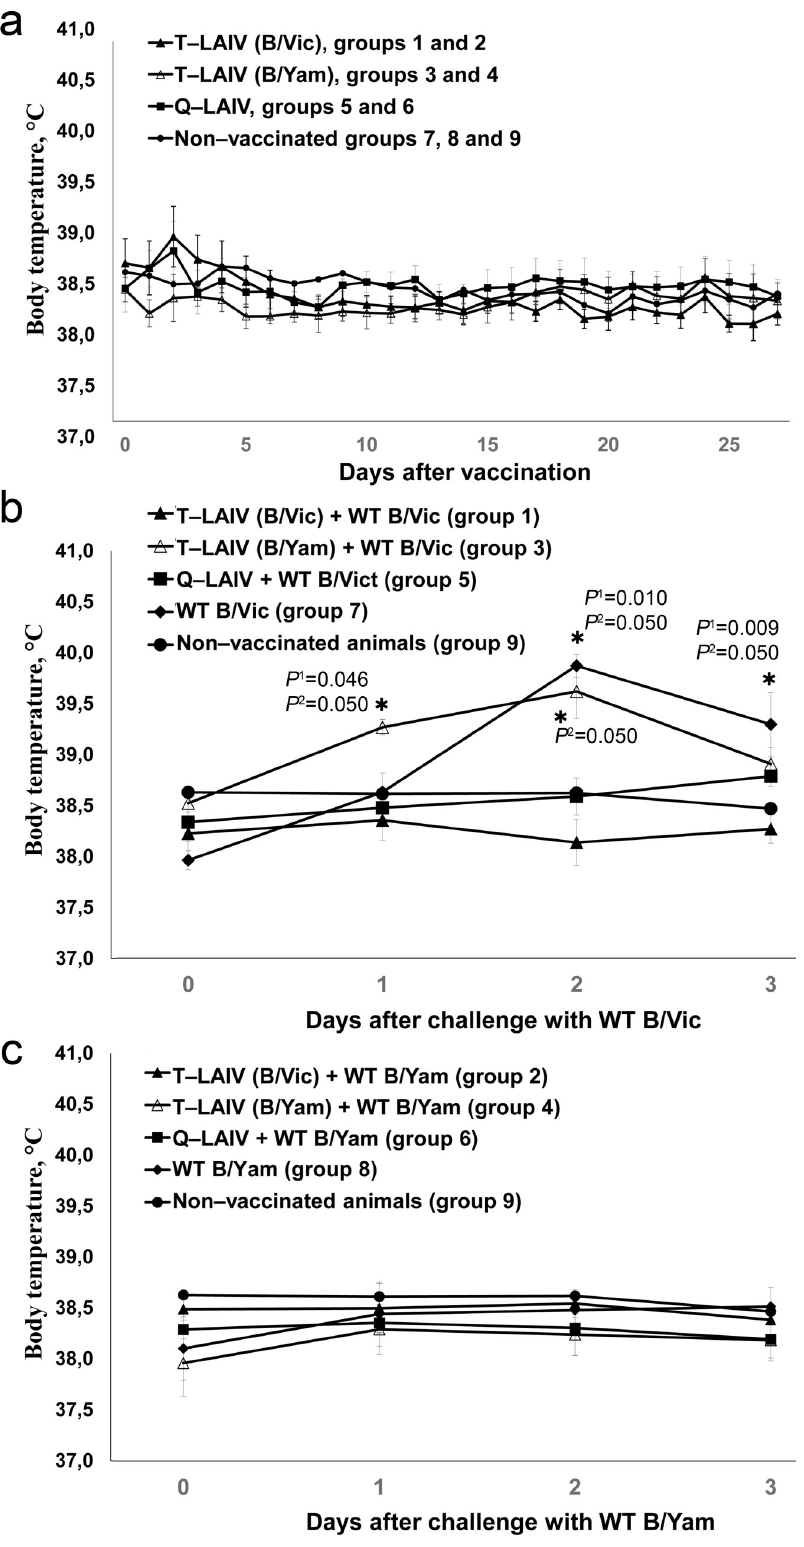
Fig 2. Body temperature of ferrets. (a) after vaccination with T-LAIVs, Q-LAIV or PBS; (b) after challenge with WT B/Vic following by vaccination with T-LAIVs, Q-LAIV or PBS; (c) after challenge with WT B/Yam following by